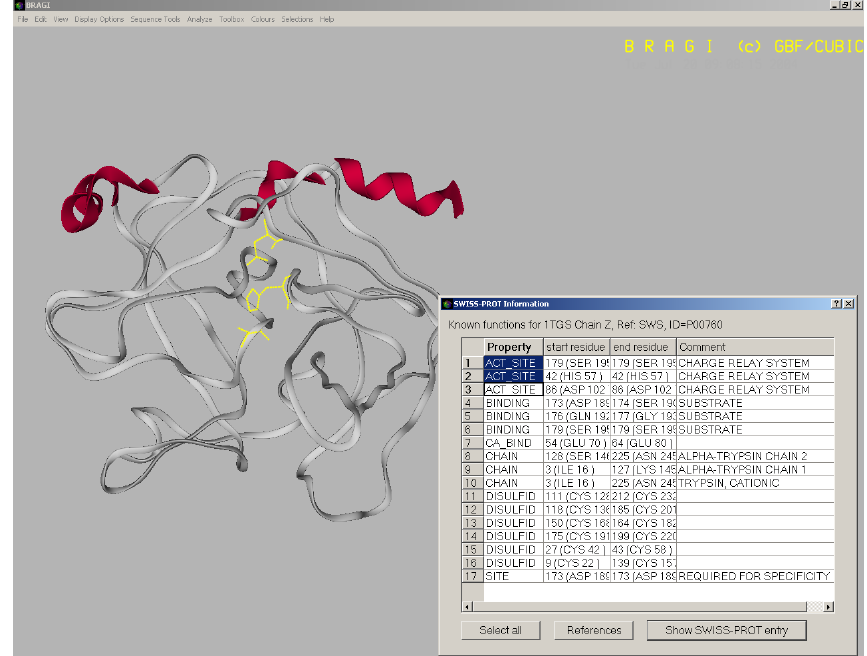
Fig. 4 Screenshot of the 3D-viewer BRAGI [11]. Functional annotations as extracted from the corresponding SWISS-PROT entry P00760 are shown in the “SWISS-PROT Information” window. The user queried the PDB entry, 1TGS and chose the active sites (Nr. 1-3, Act_Site) from this window. The requested information is yellow highlighted in the 3D structure (main window).